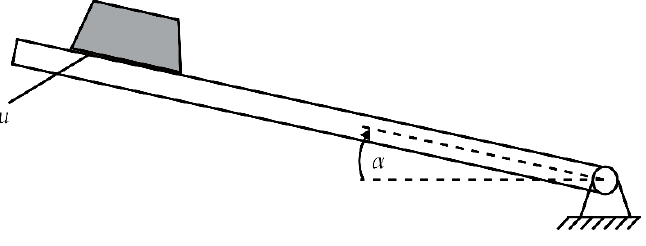
Figure 3. Schematic structure of the investigated machine.